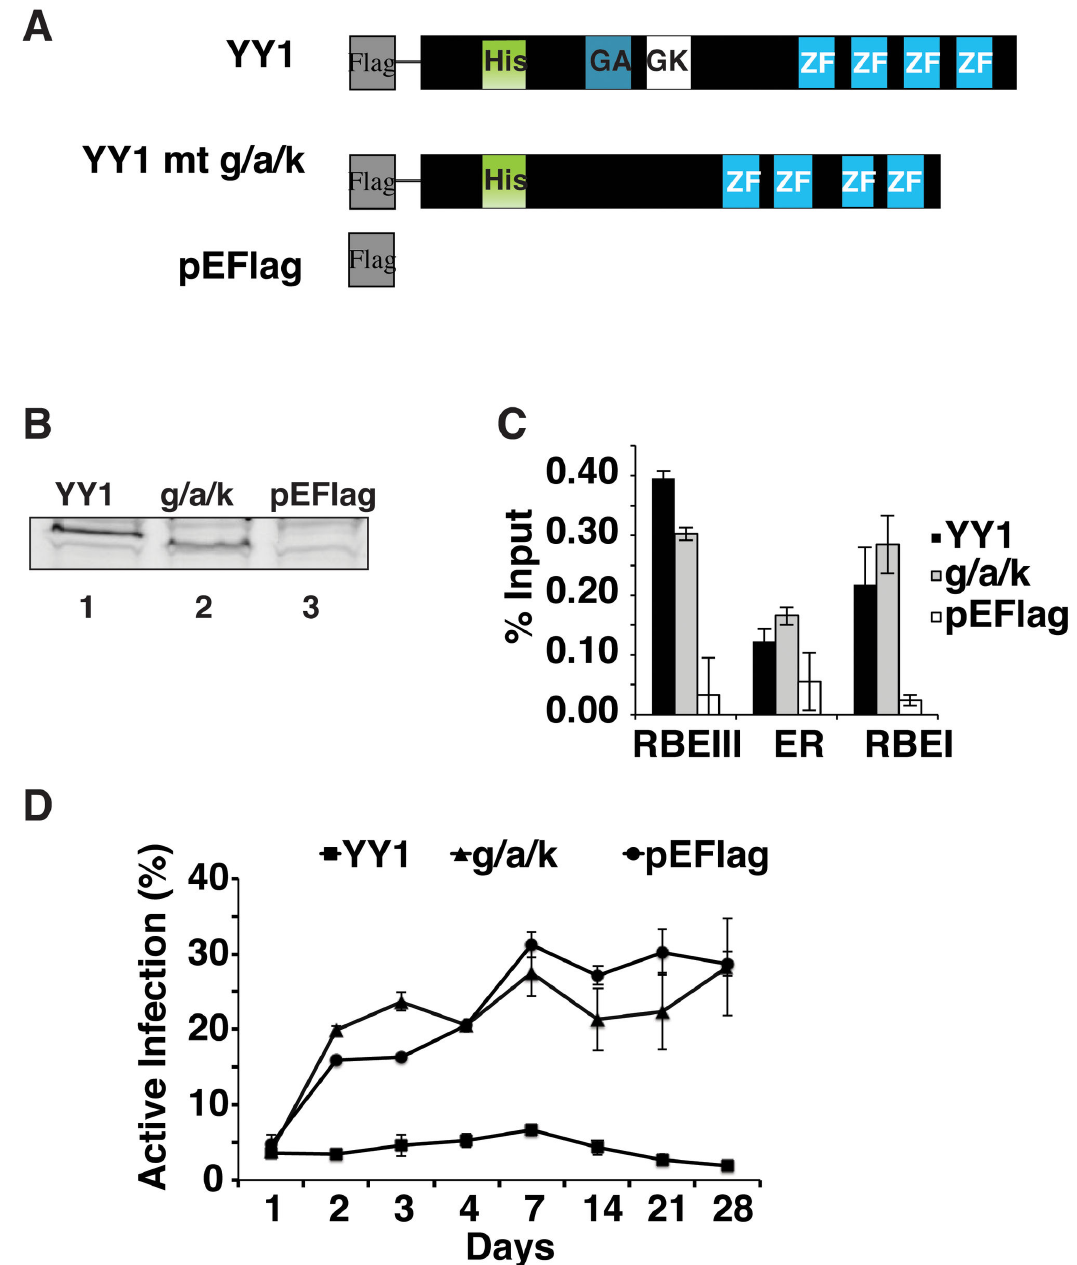
Figure 6. YY1 overexpression increases the proportion of virus that maintains latent infection. Panel A : Schematic representation of expression constructs: wild type YY1 (YY1), a YY1 deletion mutant lacking the HDAC1 interaction region (g/a/k) and vector control (pEFlag) used to produce stable cell lines. Indicated are a histidine rich region (His), the glycine/alanine (GA) and glycine/lysine (GK) rich regions, and the zinc finger domains (ZF) DNA binding domain. Panel B : Immunoblot of cell extracts from stable lines transfected with the YY1 (lane 1), g/a/k YY1 mutant (lane 2) and vector control (lane 3) with α-Flag antibody. Panel C : ChIP was performed on pools of stably transfected Jurkat-tat cells overexpressing YY1, the g/a/k YY1 mutant or the vector control, infected with the wild type reporter virus using α-Flag antibody, and the primer sets as described in Figure 2B. Panel D : Stably transfected Jurkat-tat cells overexpressing YY1, the g/a/k YY1 mutant or the vector control were infected with the wild type pTY-LAI- dsRed reporter virus construct. Flow analysis was performed every 24 hours for 4 days and every week for a month post infection. The % active infection was calculated by dividing the number of cells with active HIV-1 LTR (eGFP and dsRed expressing cells) by the number of infected cells (total eGFP expressing cells). doi: 10.1371/journal.pone.0077052.g006 PLOS ONE |